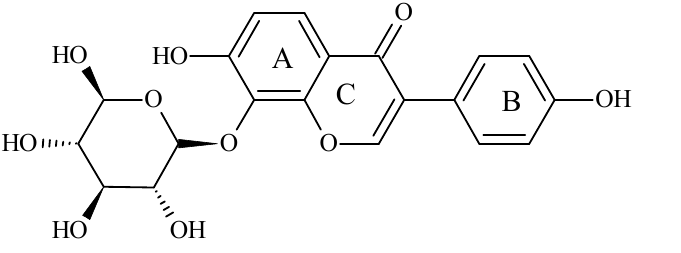
Figure 1. Chemical structure of puerarin. (IUPAC name: 8-( β -D-glucopyranosyl)-4 ′ ,7-dihydroxy- isoflavone)